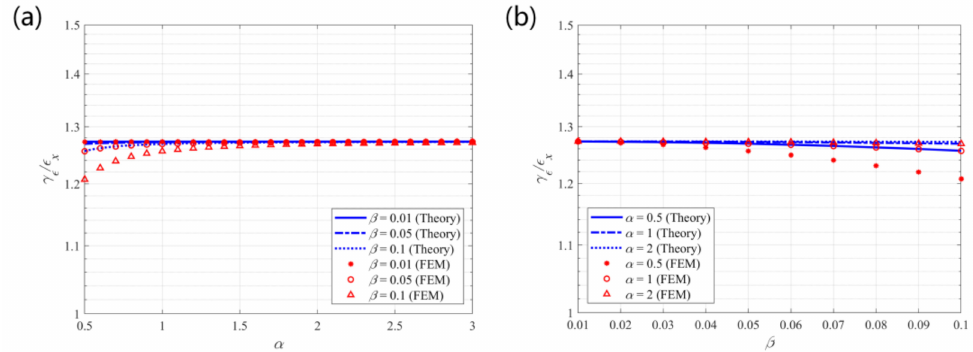
Figure 8. Theoretical predictions and finite element results for the coupling effect γ ε / ε x vs. ( a ) α ; ( b ) β